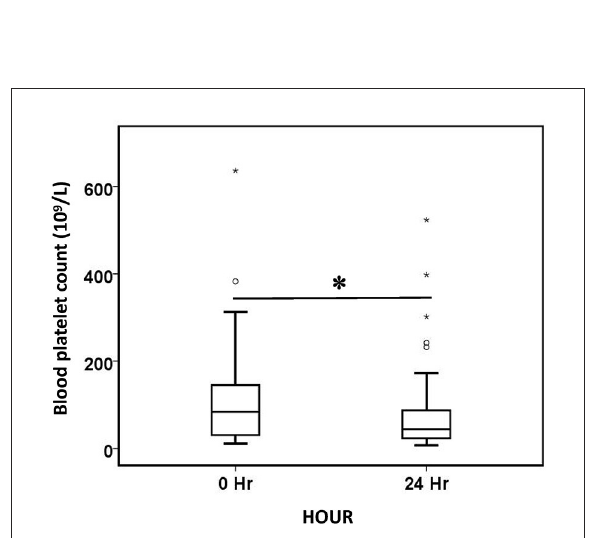
FIGURE5 Comparison of blood platelet count before (0h) and after (24h) oXiris-CHFA treatment. *P < 0.001. The symbol * stands for